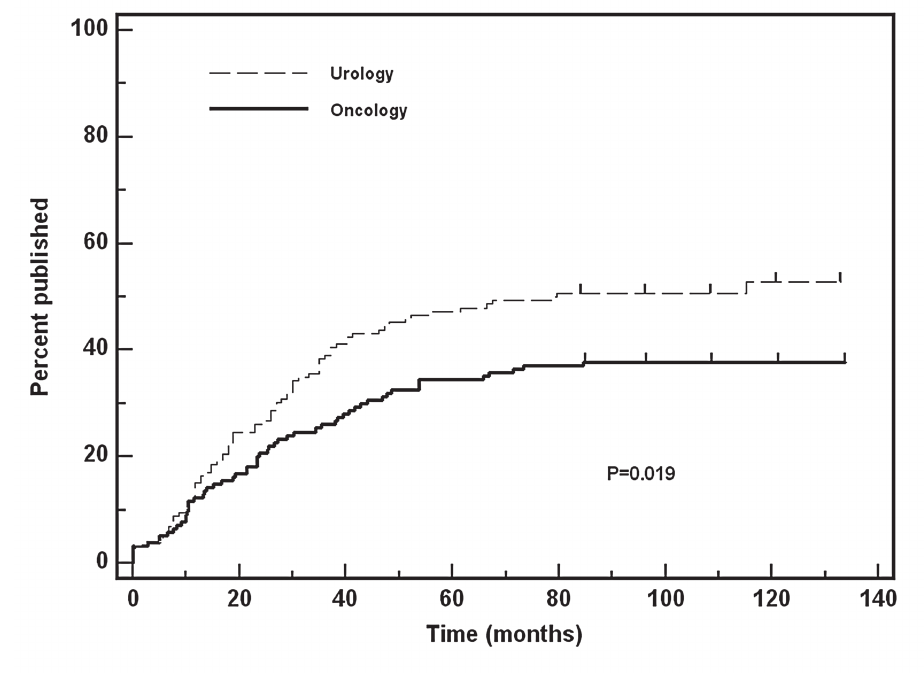
Figure 4 - Time to full publication of Brazilian studies presented the American Urological Association and American Society of Clinical Oncology Annual Meetings 2001 through 2005 (data for oncology were updated from Saad et al. 13 ; tick marks represent